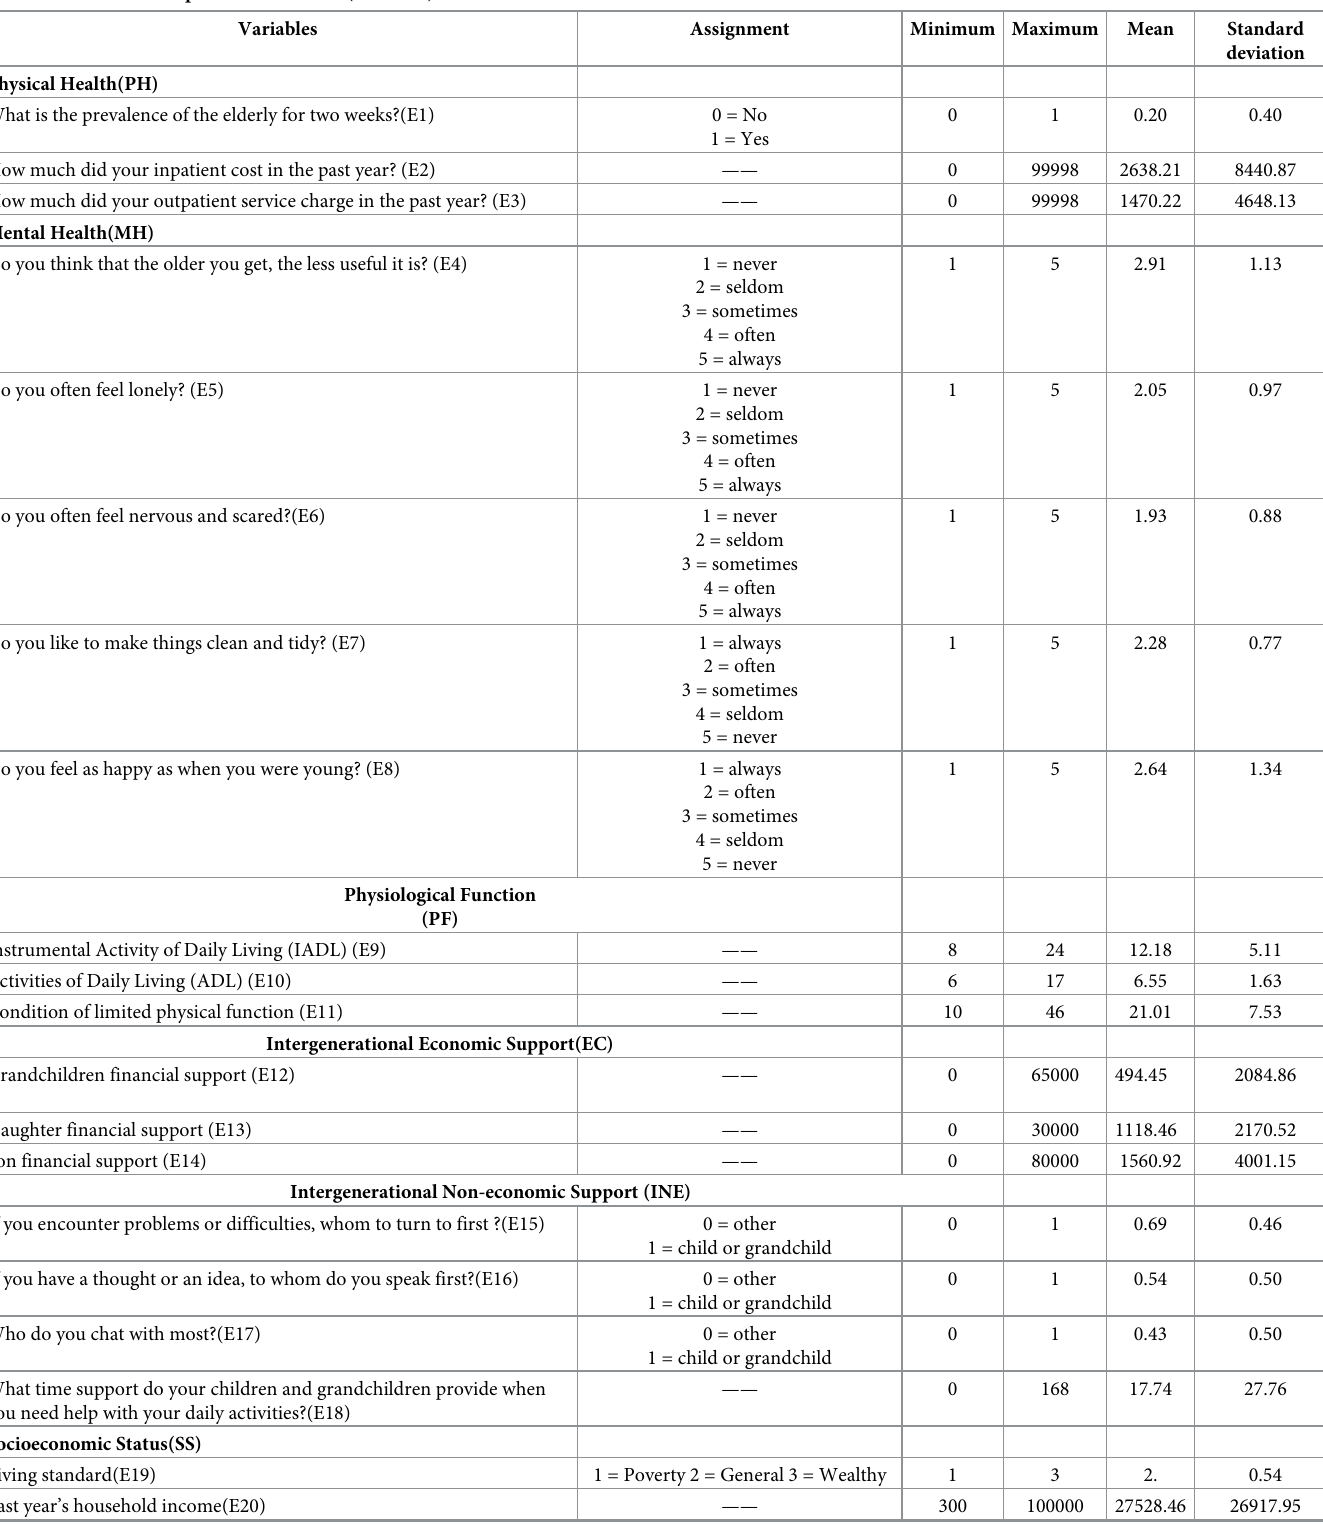
Table 1. Variable description and statistics (N =